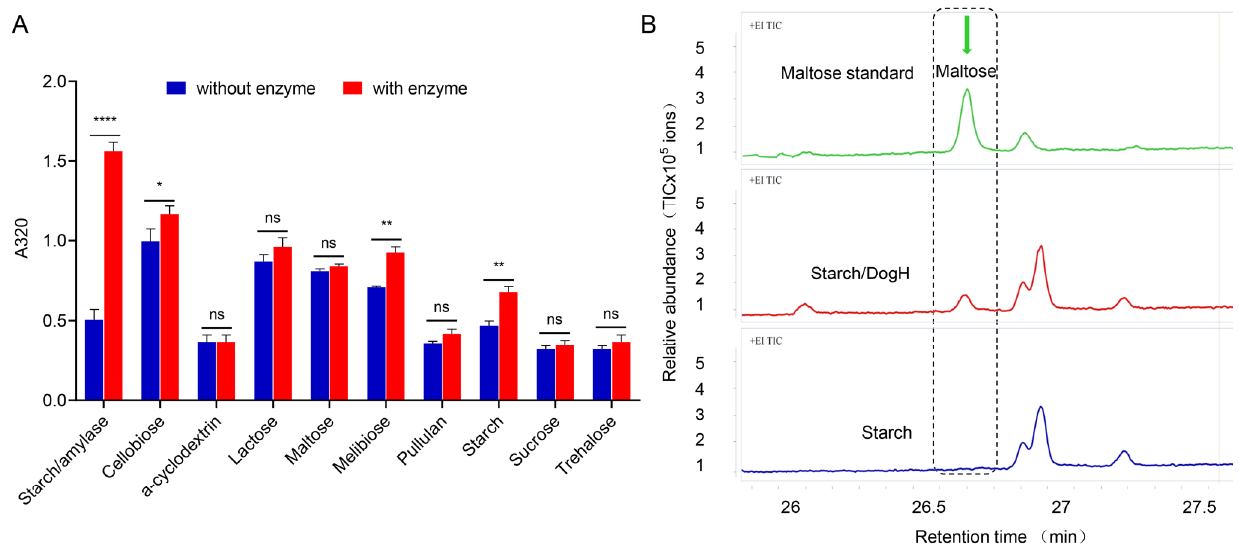
Figure 5. Substrate specificity and product analysis of DogH glycoside hydrolase. ( A ) Detection of carbohydrate breakdown. A significant difference was observed in starch/amylase control; some differences in DogH in the carbohydrate test were significant, such as cellobiose, melibiose and starch. ( B ) Quantitative determination of decomposition products of DogH glycoside hydrolase by HPLC-MS. Green peak; maltose standard; red peak: addition of DogH glucoside hydrolase to starch to produce maltose products; blue peak: no DogH glycoside hydrolase is added to starch, so maltose is not produced. One-way ANOVA and Dunnett’s multiple-comparison test; A probability value of p ≤ 0.05 was considered significant. Data are presented as averages ± SEM. ****: p ≤ 0.0001; **: p ≤ 0.01; *: p ≤ 0.05; and ns: non − signi fi cant.